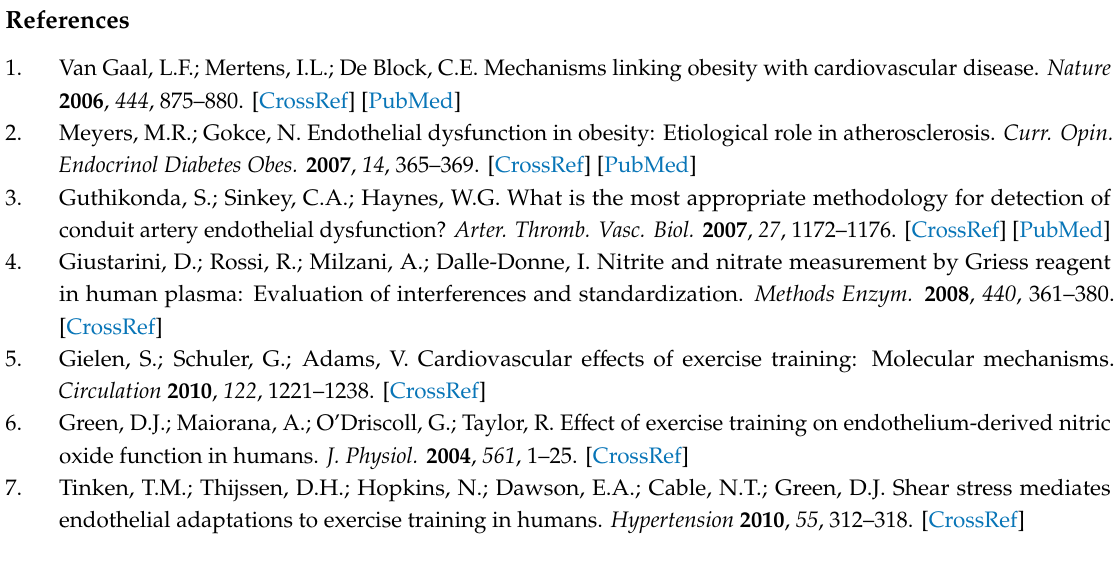
Figure S1: Correlation between resting DBP and TBARS concentration in women with obesity before endurance training. Figure S2: Correlation between resting DBP and TBARS concentration in women with obesity after endurance training. Figure S3: Correlation between resting SBP and TBARS concentration in women with obesity before the combined